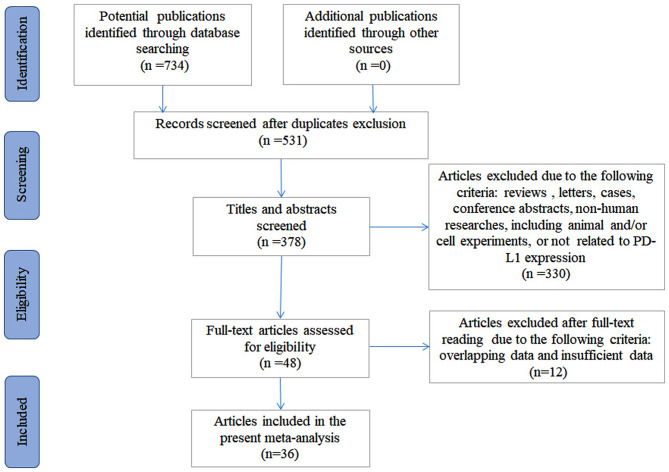
Flow diagram of the study selection process.